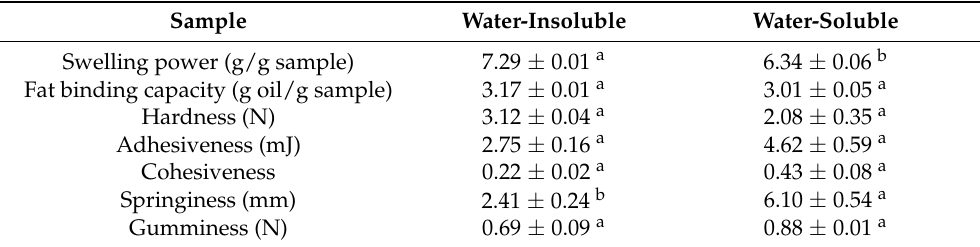
Table 2. The swelling power, fat-binding capacity, and texture profiles of water-insoluble β -glucan in oat